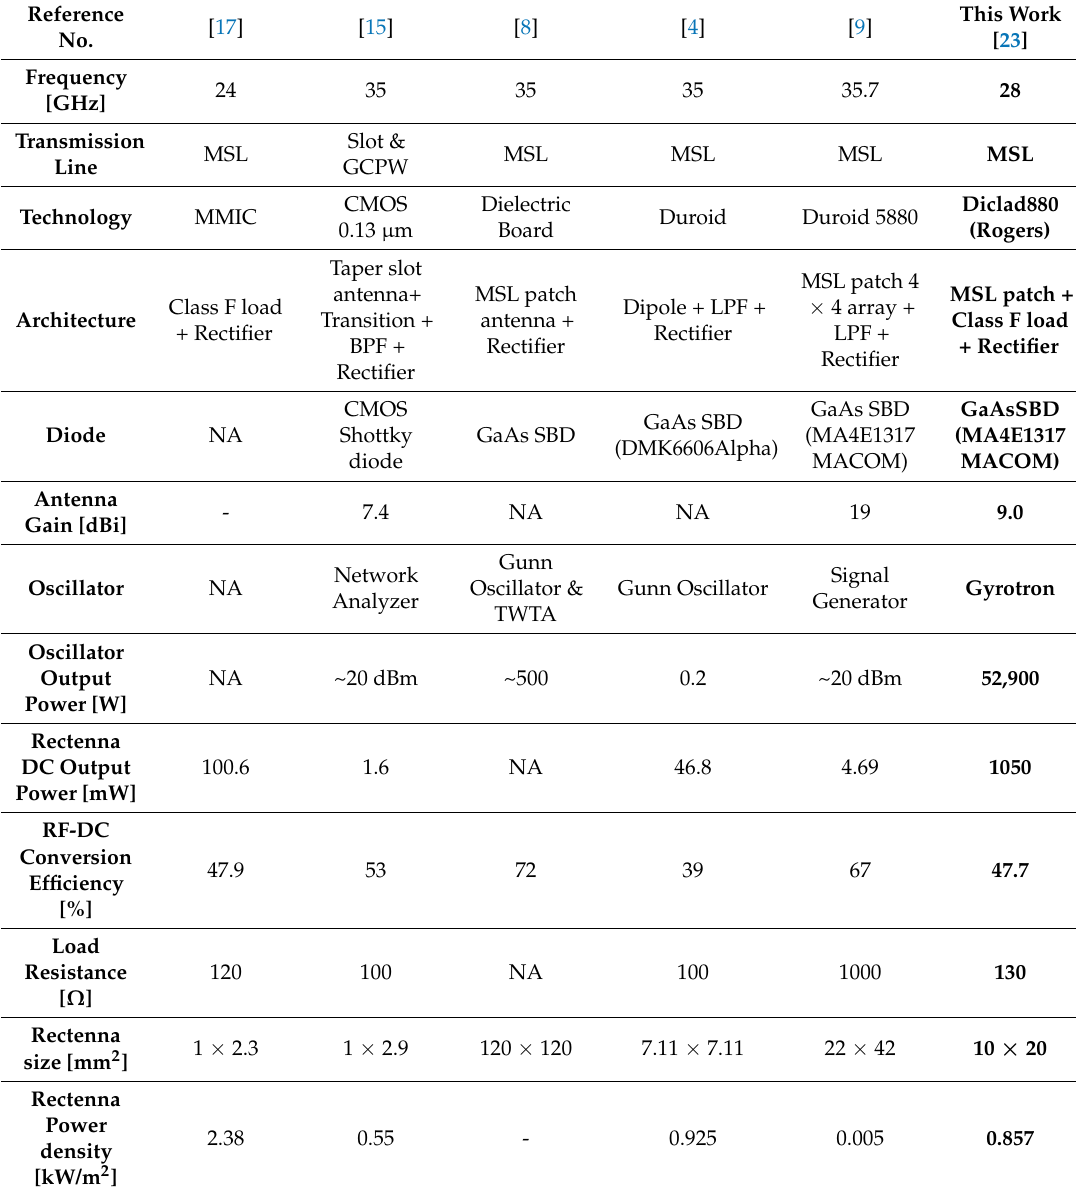
Table 2. Comparison of this work to earlier studies in K - Ka band (CPW: Coplanar waveguide, GCPW: Grounded coplanar waveguide, BPF: Band-pass filter, LPF: Low-pass